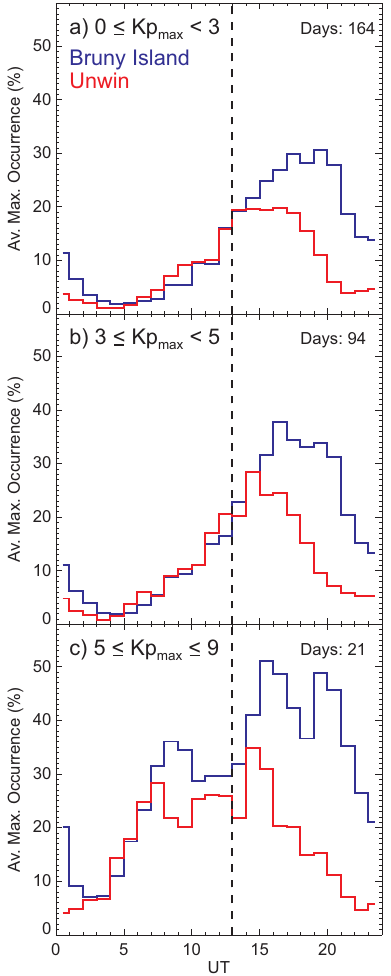
Fig. 3. The mean maximum occurrence over all days with the maxi- mum K p (a) 0 ≤ K p max < 3, (b) 3 ≤ K p max < 5 and (c) 5 ≤ K p max ≤ 9 throughout 2006. The blue (red) curve represents data measured by the Bruny Island (Unwin) radar. The number of days considered within each plot is shown in the top-right corner. Magnetic mid- night ( ∼ 13:00UT) is indicated on each plot by the dashed vertical